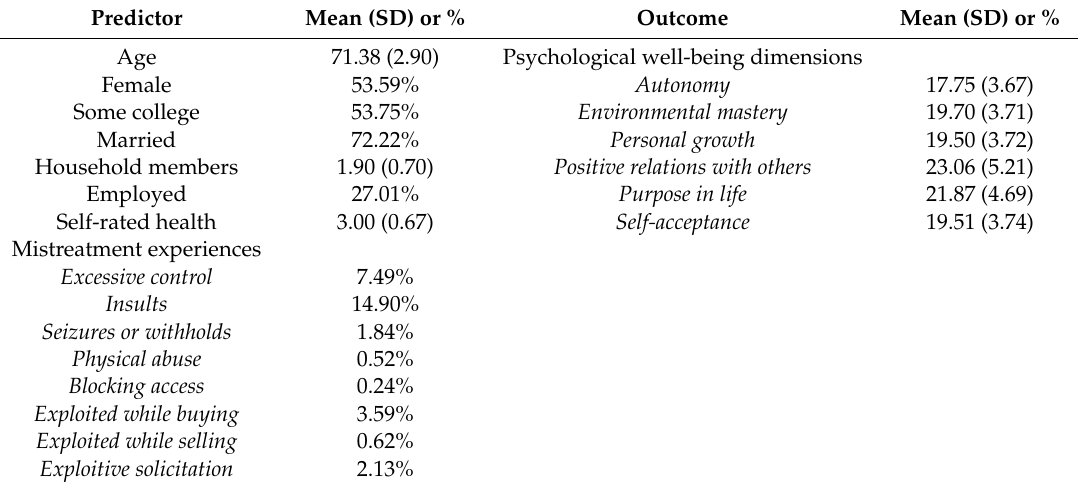
Table 3. Sample descriptives 1